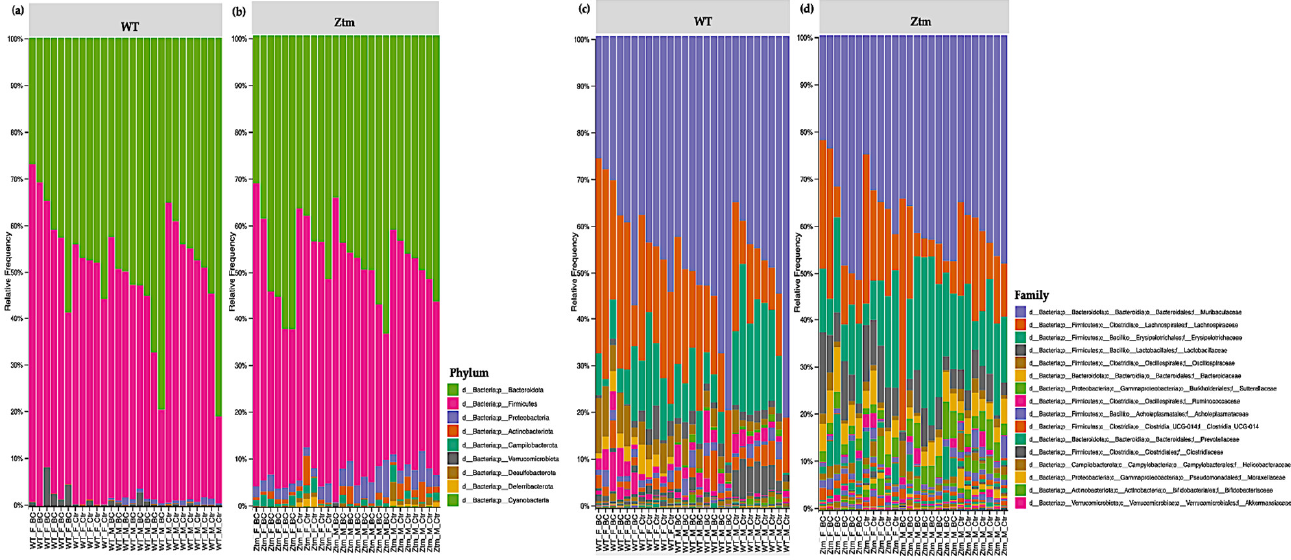
Figure 6. Taxonomy representation at phyla ( a ), ( b ) and family ( c ), ( d ) level. The abscissa represents the groups, and the ordinate represents the relative abundance of intestinal bacteria in WT and Ztm mice ( f & m ). ( a ): Relative percentage of most abundant phyla in each sample between WT BC groups ( n = 14) and WT control groups ( n = 13). ( b ): Relative percentage of most abundant phyla in each sample between Ztm BC groups ( n = 14) and Ztm control groups ( n = 12). ( c ): Relative abundance of bacteria at family level in WT BC and control groups. ( d ): Relative abundance of bacteria at the family level in Ztm BC and control groups. n = 53. WT = wild-type mice; Ztm = zonulin transgenic mice; BC = bovine colostrum treatment; Ctr = control mice; F = female; M = male.